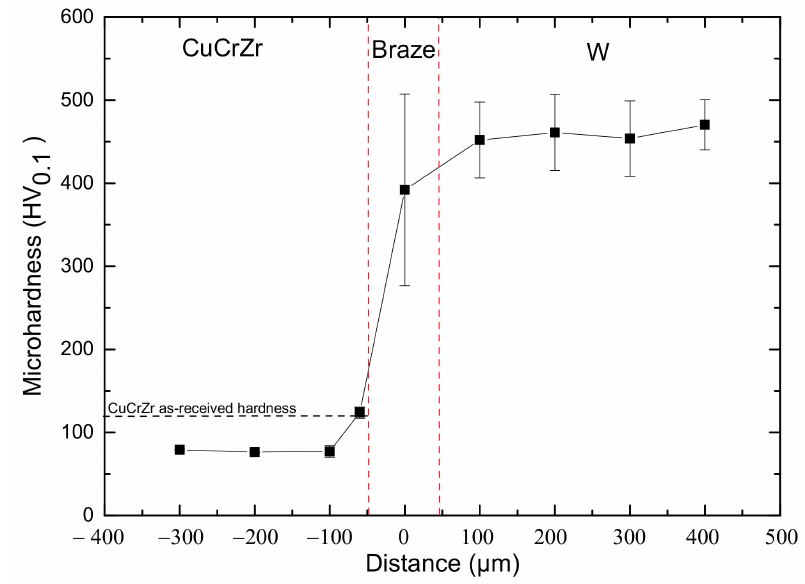
Figure 5. Microhardness profile of the W-CuCrZr brazed joint across the